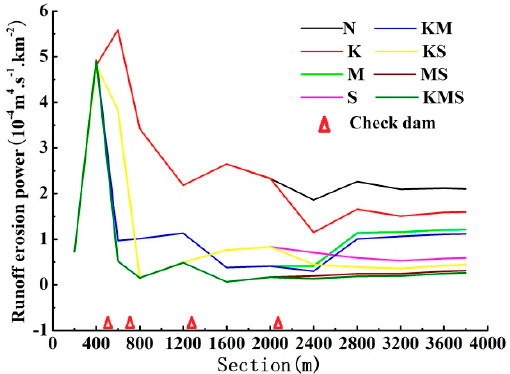
Figure 5. Distribution of runoff erosion power along the channel under different working conditions.